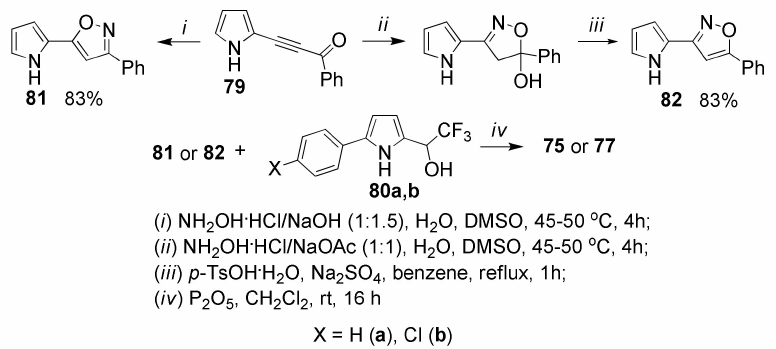
condensation of pyrrolylisoxazoles 81 or 82 and with 2,2,2-trifluoro-1-(pyrrol-2-yl)-1-ethanols 80 . 5.6. Cyclization with Methylene Active Esters: Synthesis of Pyrrolyl Pyrones The [4 + 2]-cycloaddition between 2-acylethynylpyrroles 83 and methylene active esters (Scheme 46), o ff ering a short-cut to pyrrolyl pyrones 84 in good to high yields, was described [84].